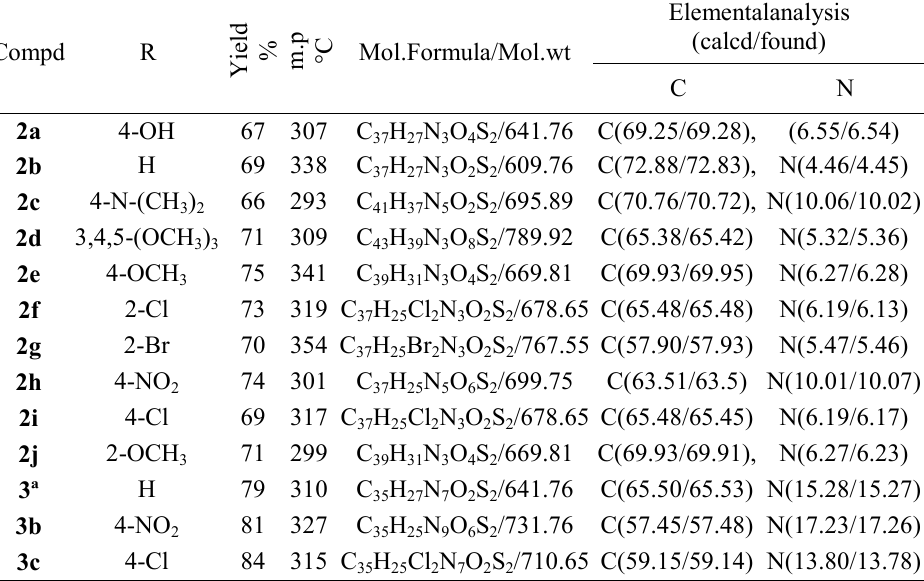
Table 1. Physical and analytical data of compounds 2a-j &